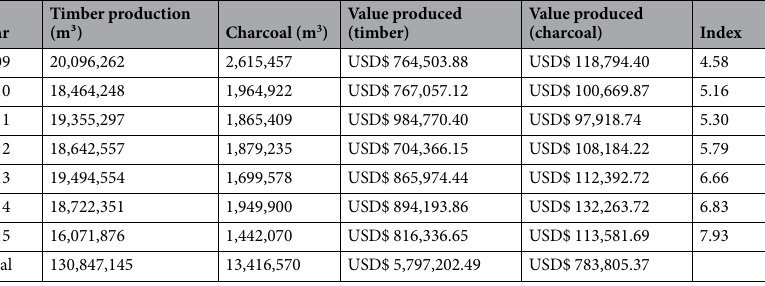
Table 3. Production and value produced by forestry extraction in the period from 2009 to 2015 in Brazilian Amazonian States and the index of value produced (USD$)/production (m 3 ). Note:The conversion result of the exchange value of R$ (Real) to USD$ (United States Dollar) in the period of the study (2009–2015) was as follows: R$ 1.00 corresponded to USD$ 2.18 (CI = ± 0.12).